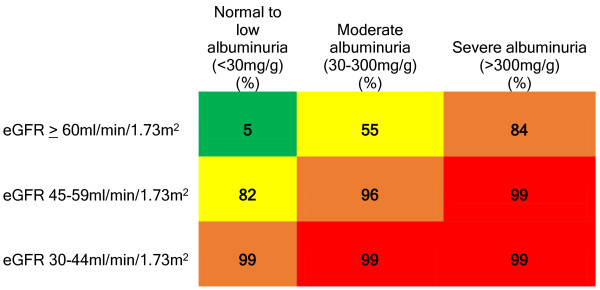
PCPs reporting that a non-diabetic older adult with the specified characteristics has CKD. Colors indicate CKD risk categories as classified in KDIGO guidelines. yellow – moderate, orange – high, red – very high. N = 154.